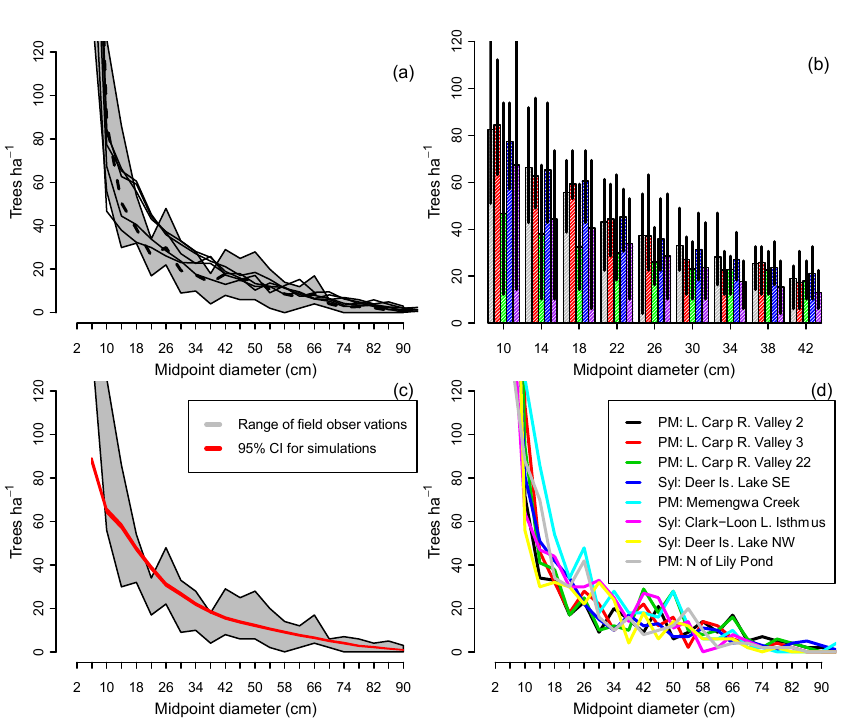
Figure 3. ( a ) Predicted diameter distribution in year 500 for the five plots shown in Figure 2 when simulated without any recruitment limitation under background mortality only (Group 1b simulations). Solid lines show the mean of the 10 replicates for each plot. Dashed line gives the mean of all ‐ aged field plots on Acer ‐ Tsuga ‐ Dryopteris (ATD) habitat, with gray band showing the range of variation; ( b ) Mean simulated densities for trees in the 10–40 cm size classes. For each size class, the five bars show the mean density for each of the five plots and whiskers indicate the range of variation among replicates; ( c ) 95% confidence band (thick red line) for 1000 ‐ year simulations under background mortality of all 70 plots compared to the range of variation among all ‐ aged field plots (gray band). The narrow confidence band in the simulations is due to the large sample size (n = 700 independent observations after 1000 years of simulation), rather than lack of stochastic variation in the model (see panel b); ( d ) Observed diameter distributions that satisfied minimum structural steady ‐ state criteria (ref. [24]) for mixed hardwoods on ATD habitat. Study area abbreviations: PM—Porcupine Mountains, Syl—Sylvania.